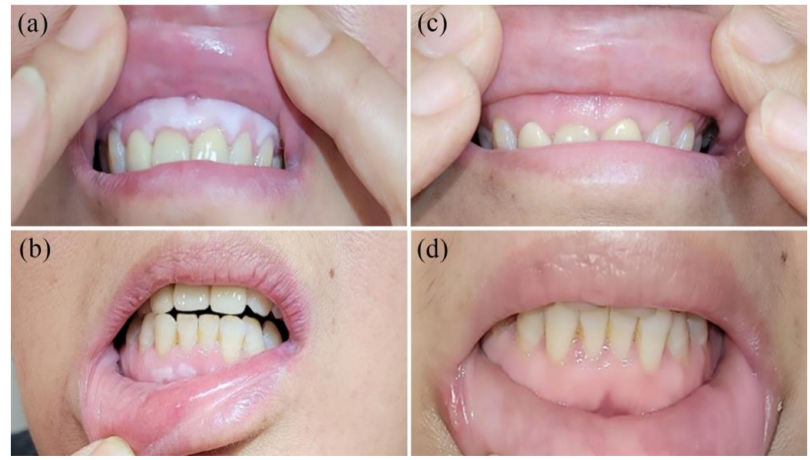
Figure 4. ( a , b ) 63-year-old male prior to treatments. ( c , d ) At 2 weeks after 4 weeks of PBMT treatments. Table 5. HRQoL according to EROTC QLQ-B30 questionnaires before and after